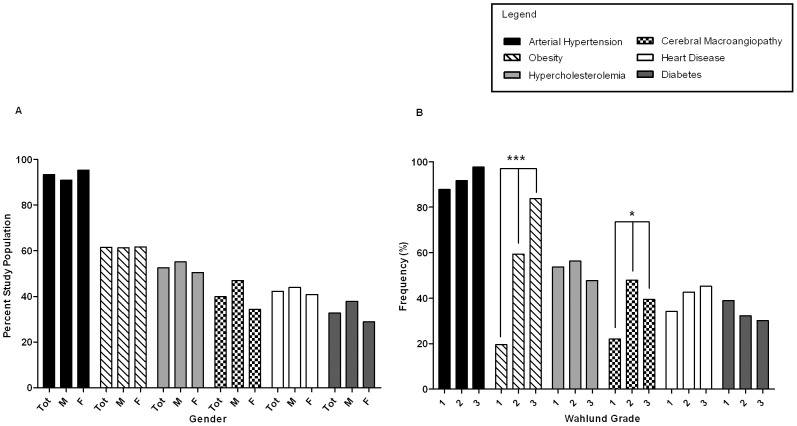
Frequency of vascular risk factors found in patients with cerebral microangiopathy.(A) The frequencies of vascular risk factors including arterial hypertension, obesity, hypercholesteremia, cerebral macroangiopathy, heart disease and diabetes are given here as percentages of total study population and broken down by gender. (B) The frequency of vascular risk factors in across different Wahlund grades (Wahlund, et al., 2001; Grade 1 =  focal lesions, Grade 2 =  confluent lesions, Grade 3 =  diffuse lesions). Occurrence of obesity (***p<.000, Pearson's chi square test) and cerebral macroangiopathy were unevenly distributed among the severity grades of WML and lacunar infarcts (p = .018, Pearson's chi square test).